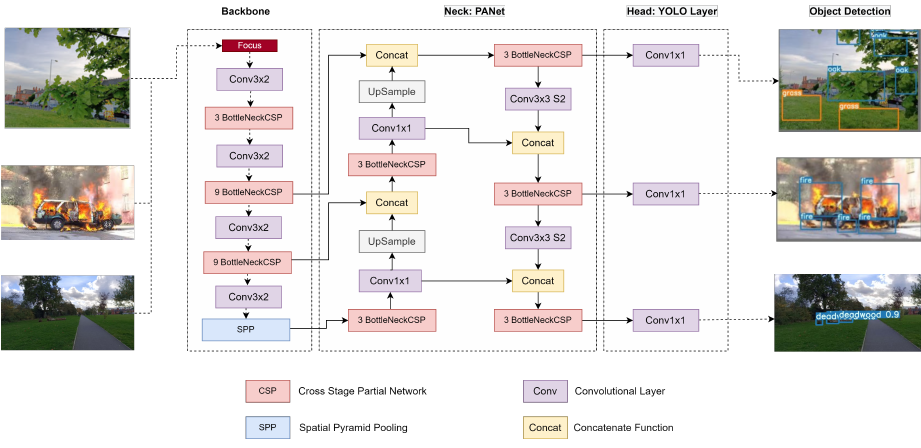
Figure 12. The architecture of